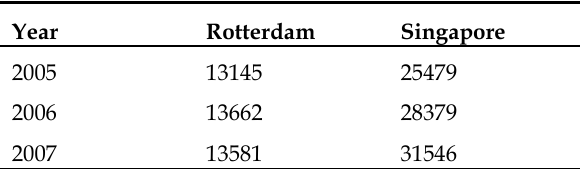
Table 1. Bunker sales in the ports of Rotterdam and Singapore in ktonnes per year